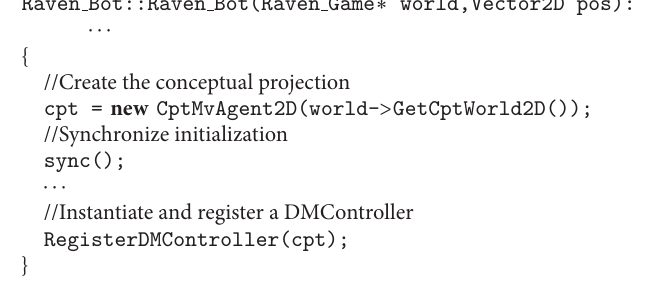
Algorithm 14: Conceptual AI registration in Graven. The RegisterDMController function is defined in the DMController module and is used to instantiate the CptBot class.